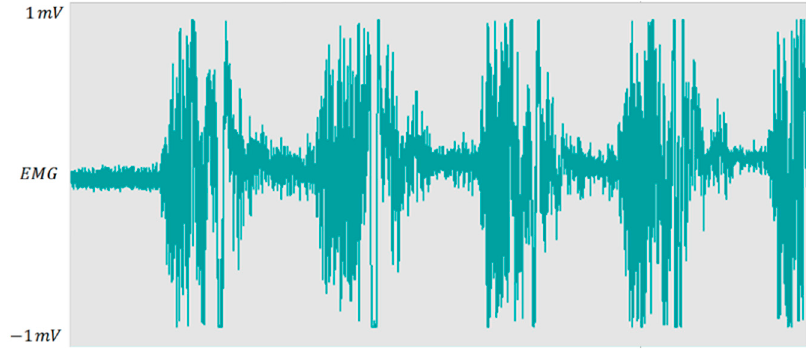
Figure 13. Result of EMG.